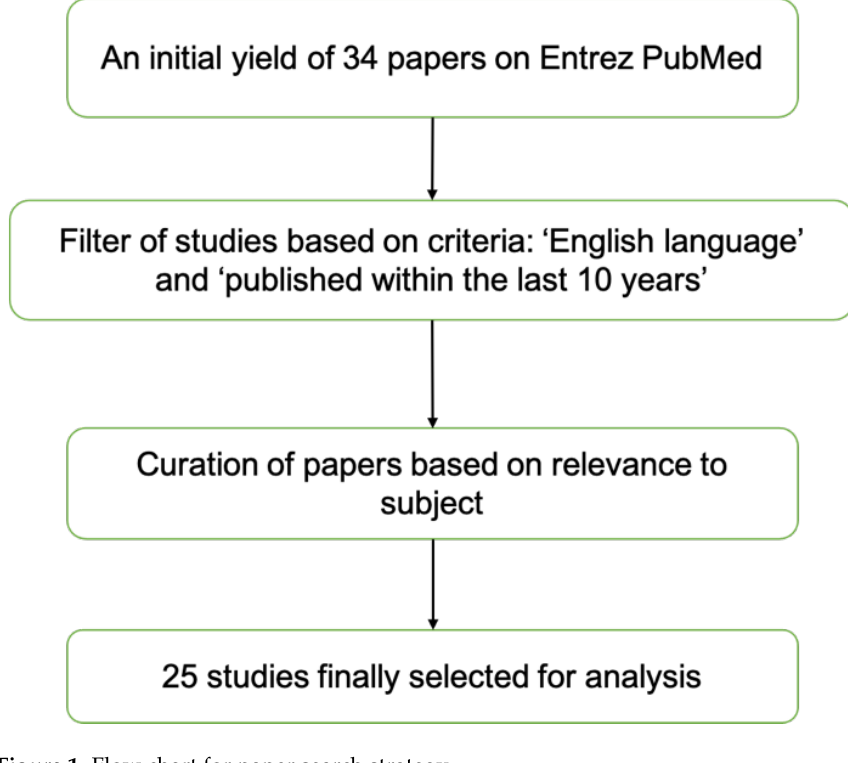
Figure 1. Flow chart for paper search strategy.